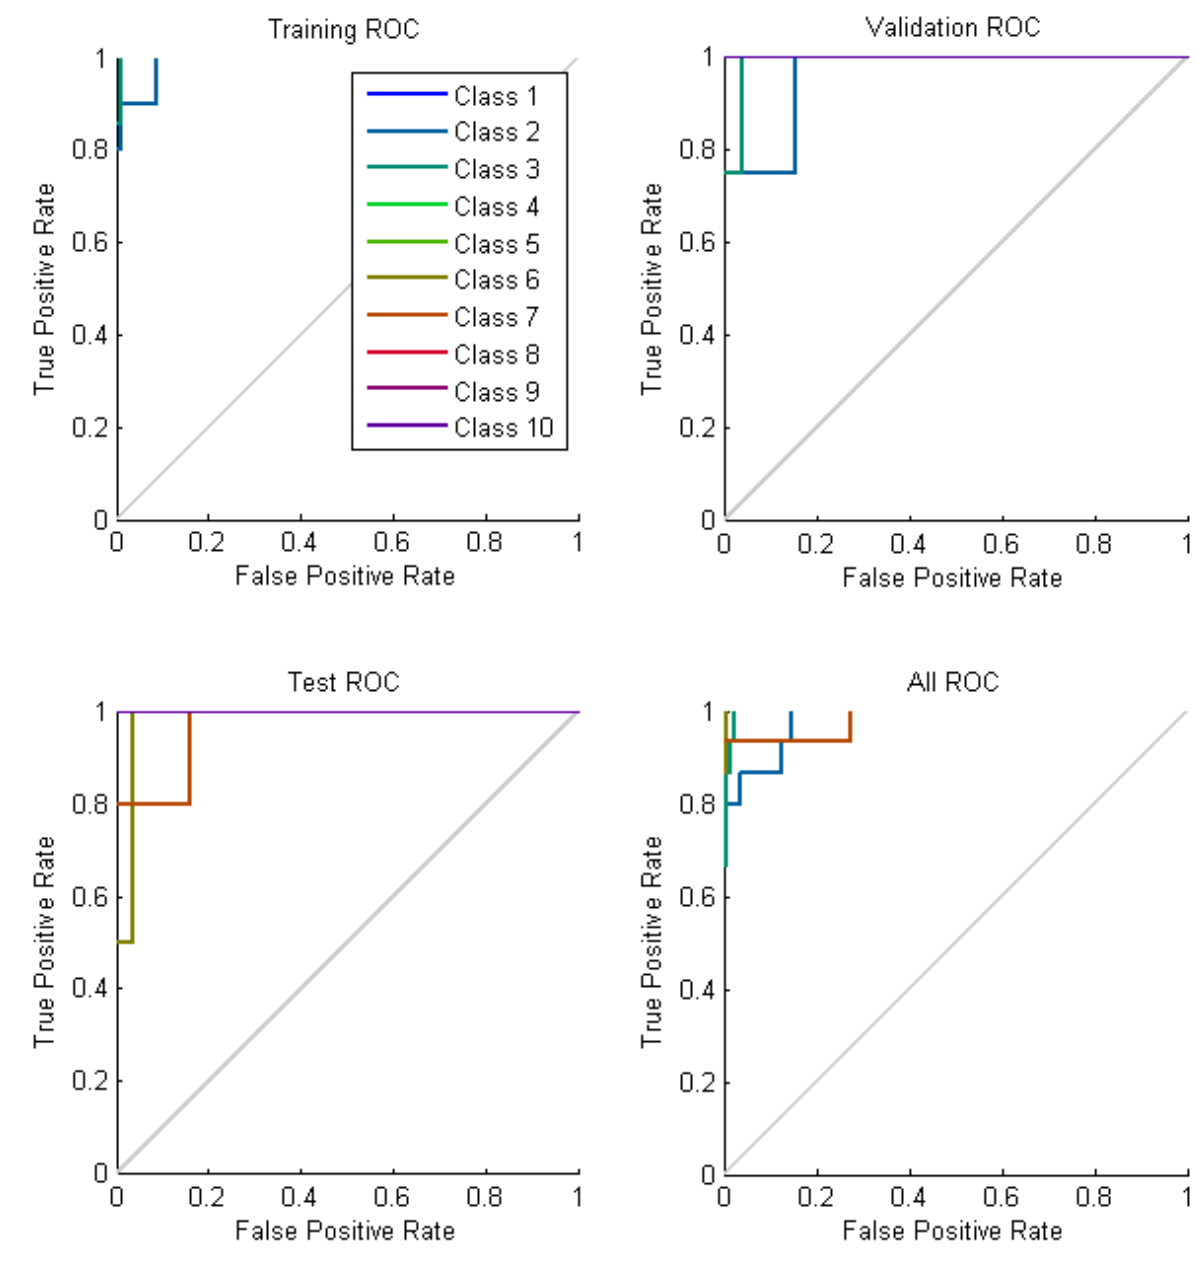
Figure 5. Receiver operating characteristic (ROC) curves for cucumber fruit classification. The analysis of 10 cucumber samples was based on the quantity of urea fertilizer applied using the electronic nose outputs as inputs.